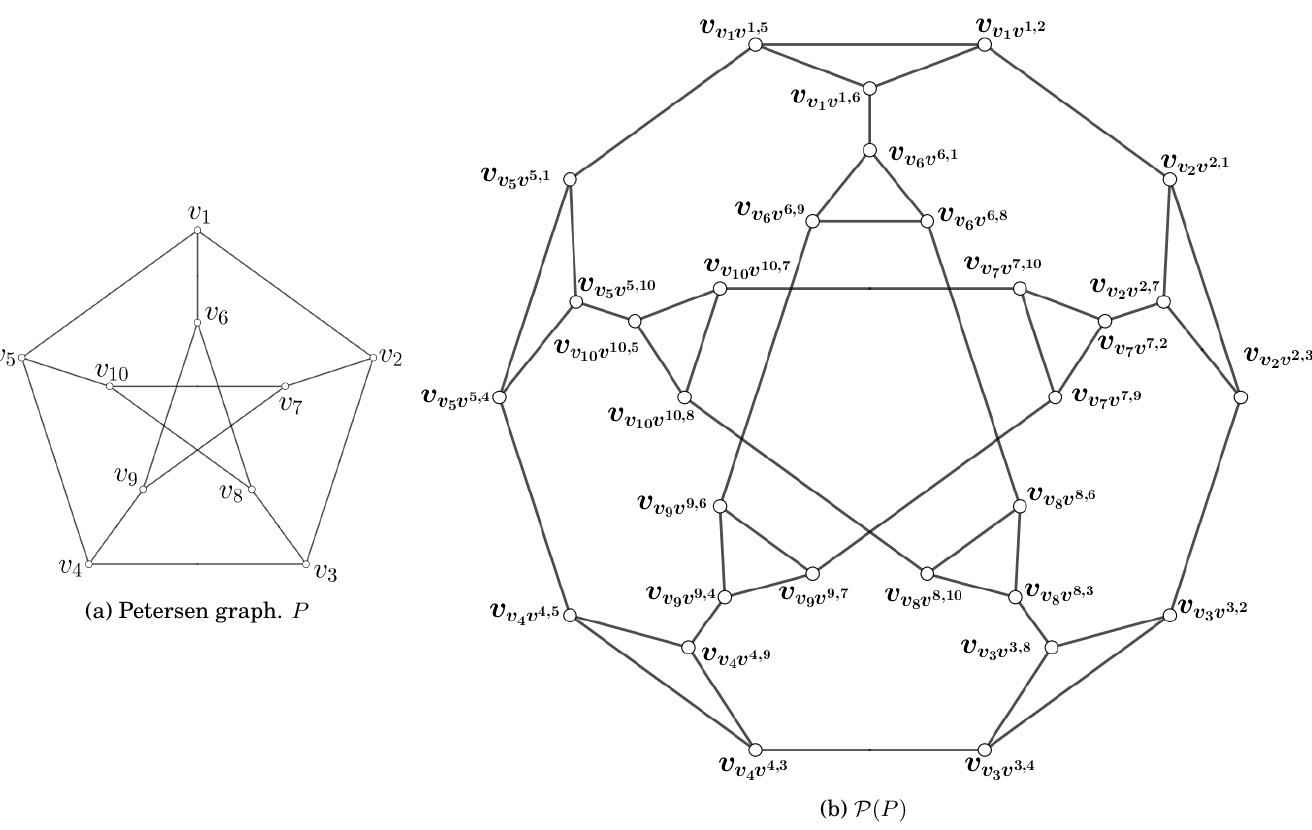
Figure 1: Petersen graph and its para-line